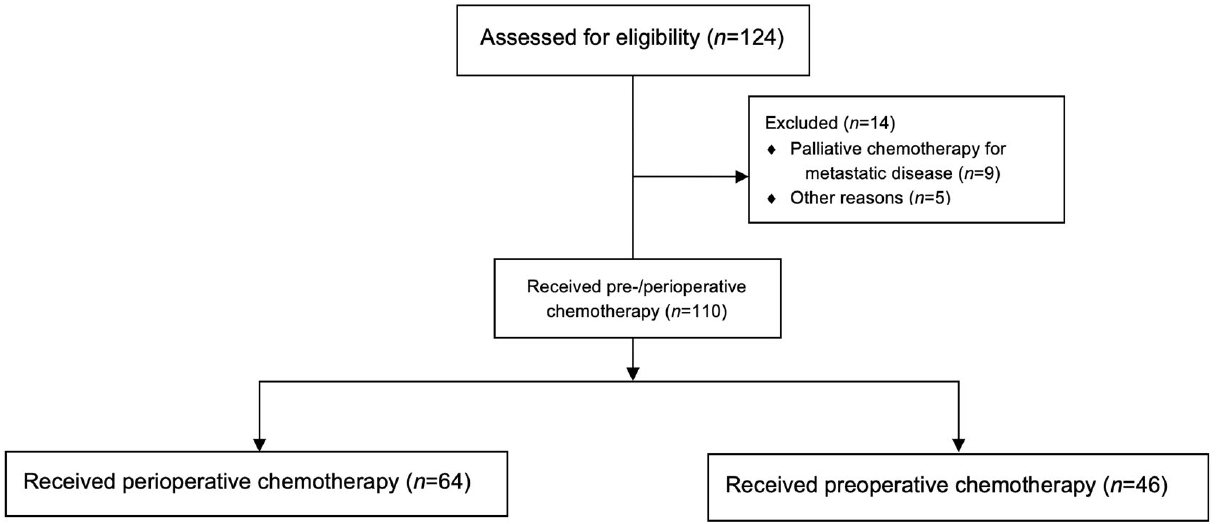
Figure 1. CONSORT flow diagram. Table 1. Patient characteristics.